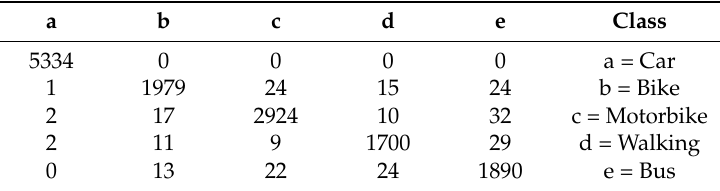
Table 8. Confusion matrix with the optimized parameters.